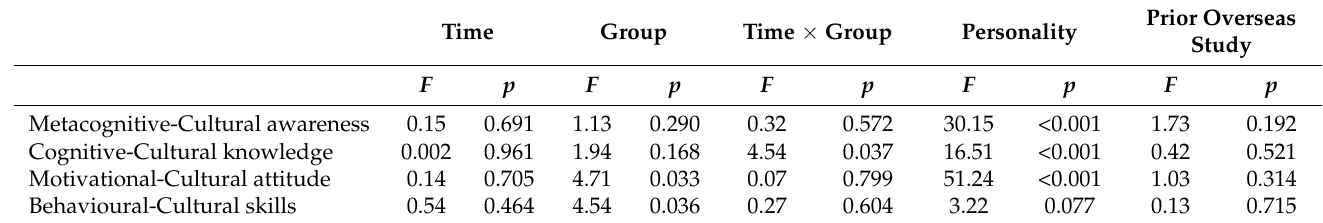
Table 3. Results of